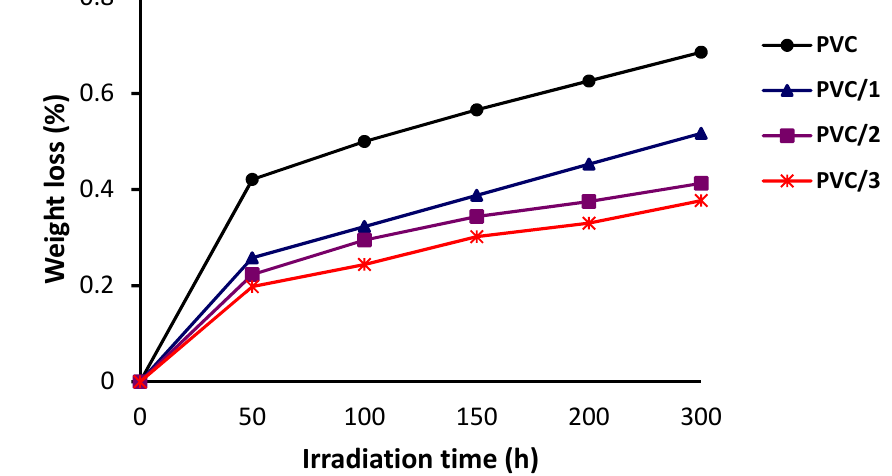
Figure 4. E ff ect of irradiation on the weight of PVC Figure 4. Effect of irradiation on the weight of PVC films.